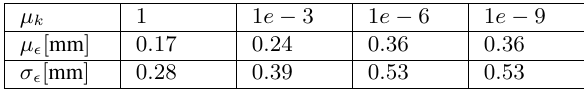
Table 3: Mean Euclidean distance error µ (cid:15) and standard deviation σ (cid:15) for different values of µ